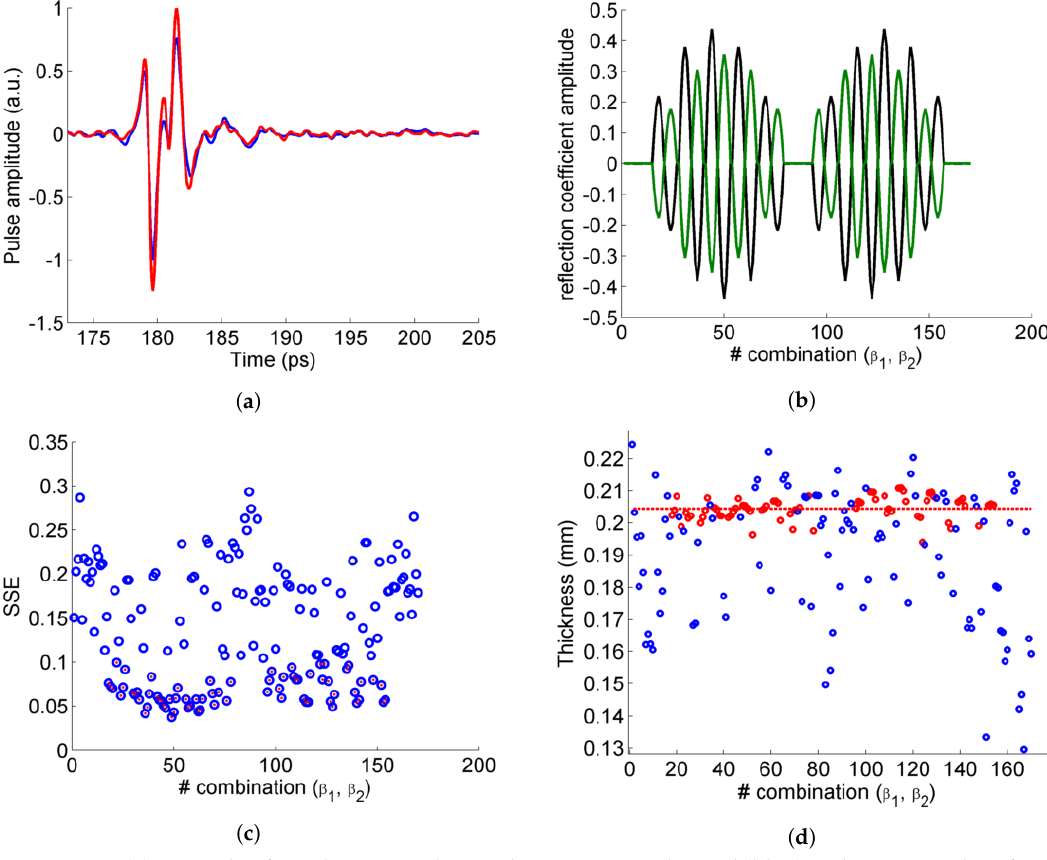
Figure 5. ( a ) Example of overlapping pulses in the experimental signal (blue) and corresponding fit (red). ( b ) Amplitude of reflection coefficients from first interface r 1 (black) and backside r 2 (green). ( c ) Sum of squared estimate of erros (SSE) for each fit (blue circles), selected points of low SSE (red dots). ( d ) Thickness obtained from the fits with high SSE (blue dots) and low SSE (red dots), as well as averaged thickness value (red